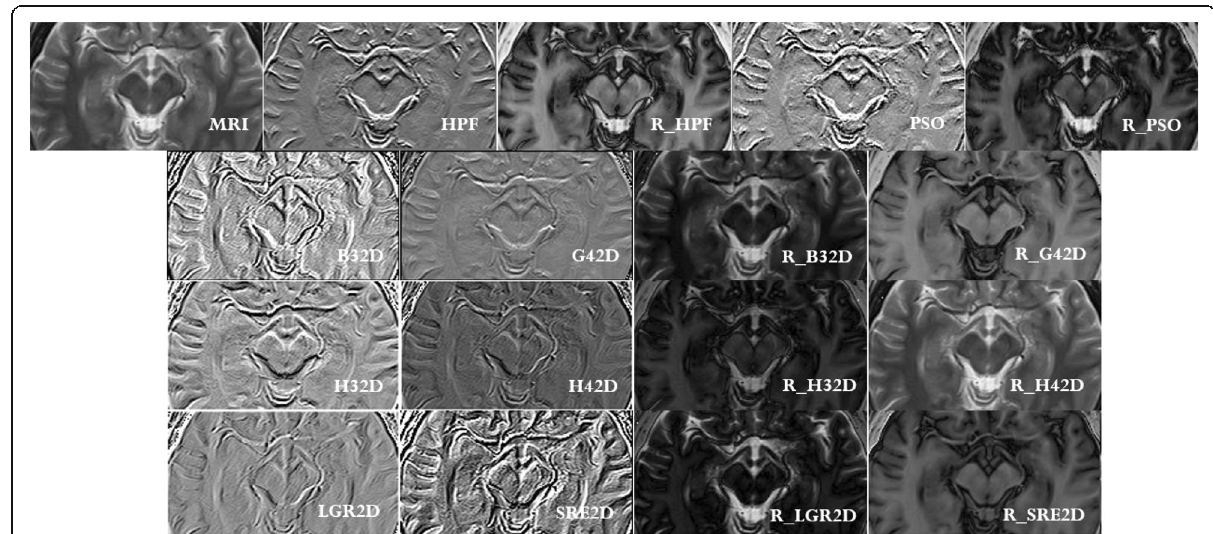
Fig. 8 Comparative study across filtering techniques. Top row (from left to right): MRI, HPF, reconstructed MRI through HPF (R_HPF), PSO-based HPF, and reconstructed MRI through PSO (R_PSO). Second row: ICF of B32D, ICF of G42D, reconstructed MRI through ICF of B32D (R_B32D), and reconstructed MRI through ICF of G42D (R_G42D). Third row from the top: ICF of H32D, ICF of H42D, reconstructed MRI through ICF of H32D